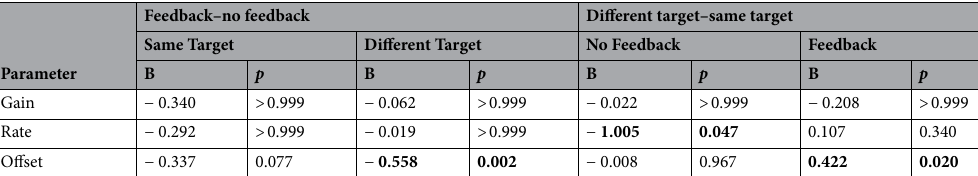
Table 1. Simple main effects analysis of exponential decay coefficients extracted from the hierarchical nonlinear mixed effects model. P -values are Holm–Bonferroni corrected for 12 planned comparisons. Bolded comparisons indicate p <